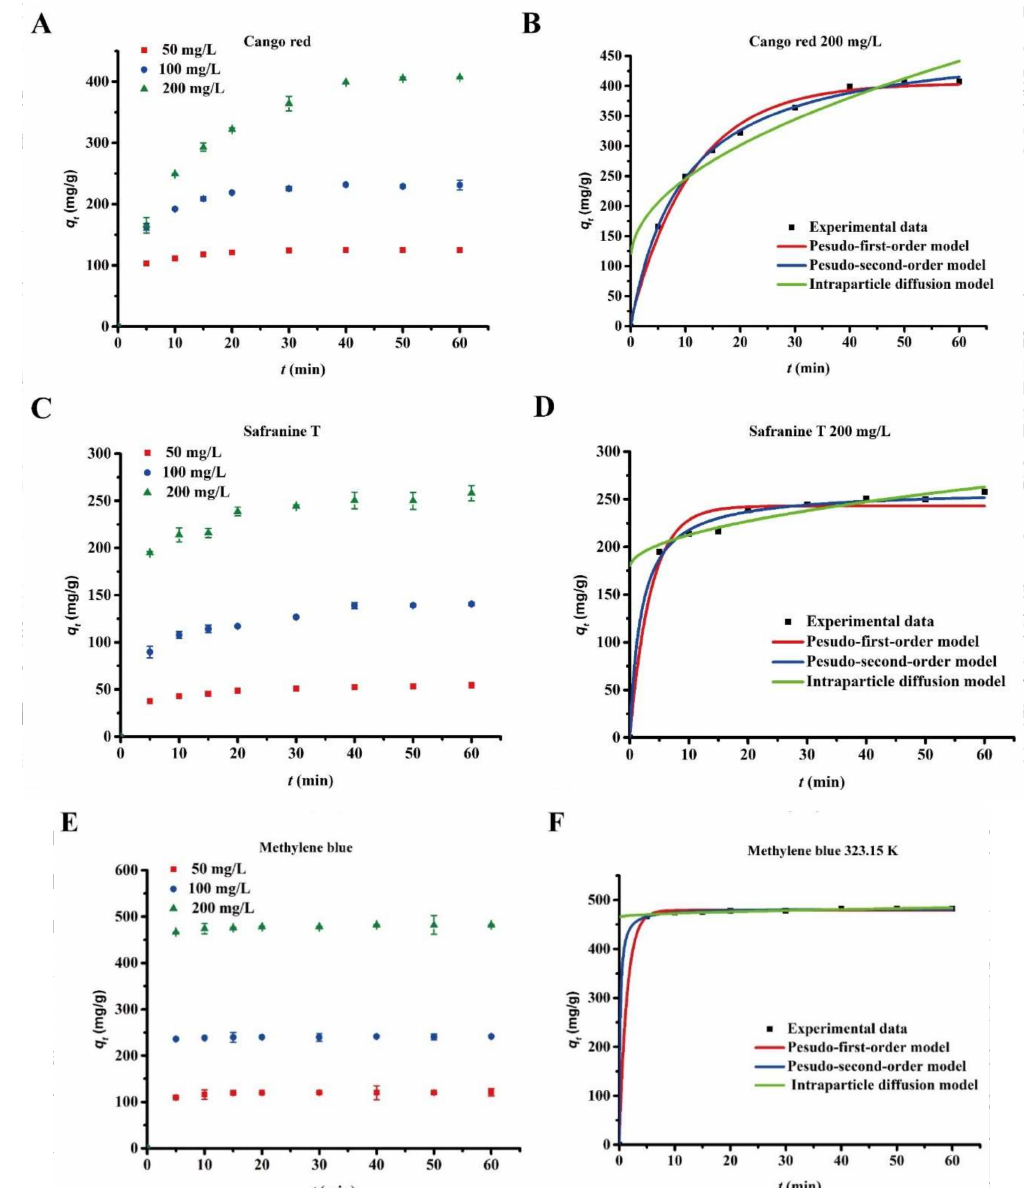
Figure 5. Effect of contact time on the adsorption of dyes at different initial concentrations. 50, 100 and 200 mg/L of congo red ( A ); safranine T ( C ); and methylene blue ( E ) were completely removed by 0.4 g/L of Bio-SeNPs. Data are shown as the mean ± SD of three replicates. The average values of congo red ( B ); safranine T ( D ); and methylene blue ( F ) with initial concentrations of 200 mg/L were used for the pseudo-first-order, pseudo-second-order and intraparticle diffusion model